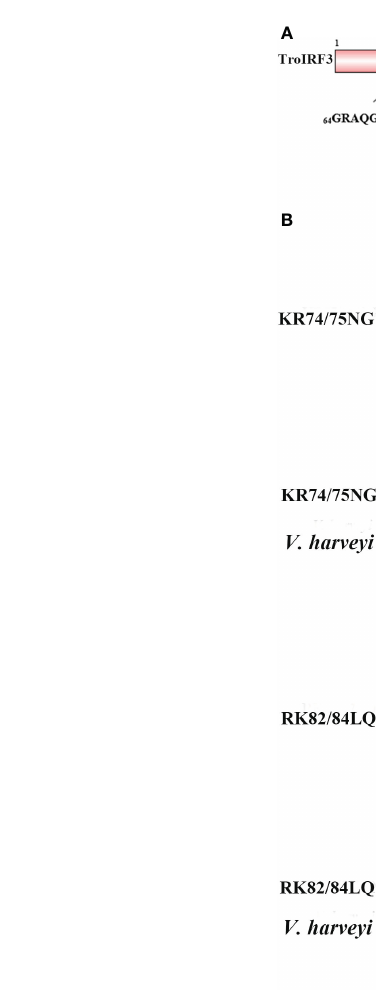
FIGURE 5 Subcellular distribution of nuclear import of TroIRF3 variants. (A) Schematic presentation of different TroIRF3-GFP variants. (B) The subcellular distribution of TroIRF3 variants with or without V. haveyi infection. GPS cells seeded overnight on a microscope in 24-well plates were transiently transfected with TroIRF3 variants for 48 h. The cells were stimulated by V. haveyi for 6 h, followed by inverted fl uorescence microscopy imaging. DAPI was used to stain the nuclei of